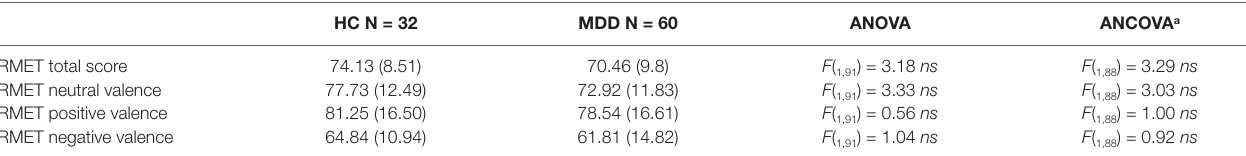
TABle 3 | RMET data: comparison of healthy controls with patients with